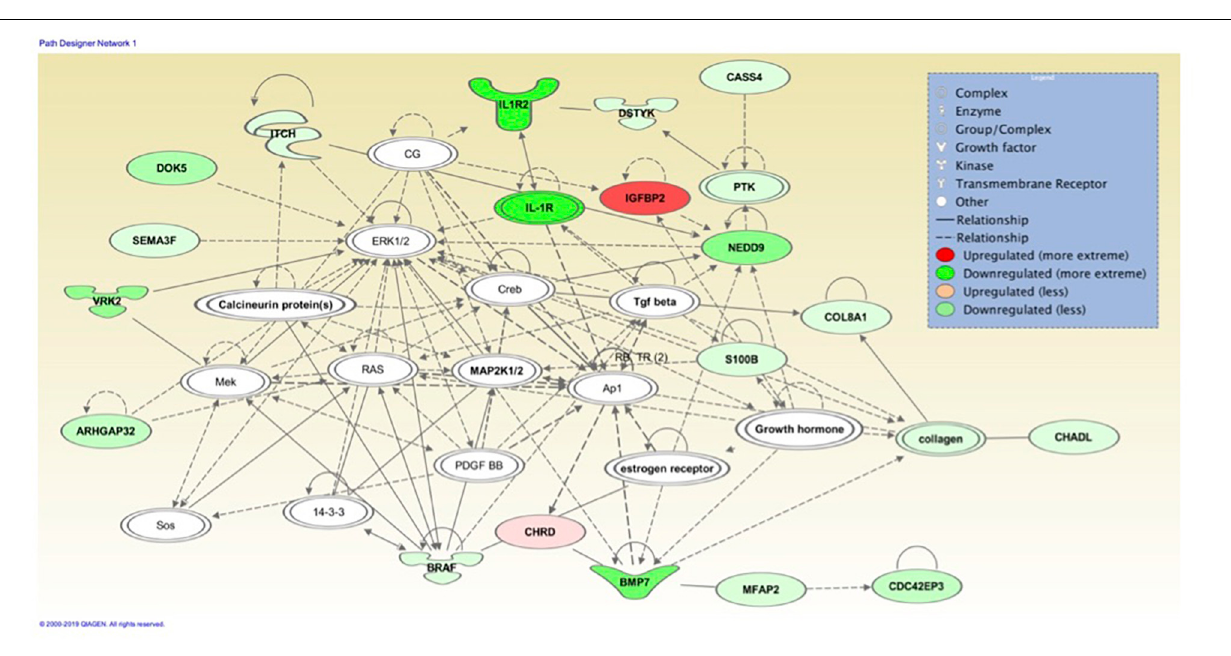
FIGURE 8 | Associated network function in IPA for the liver transcriptome dataset of birds with normal PM compared to severe/moderate WB: Cell Cycle, Embryonic Development, Cellular